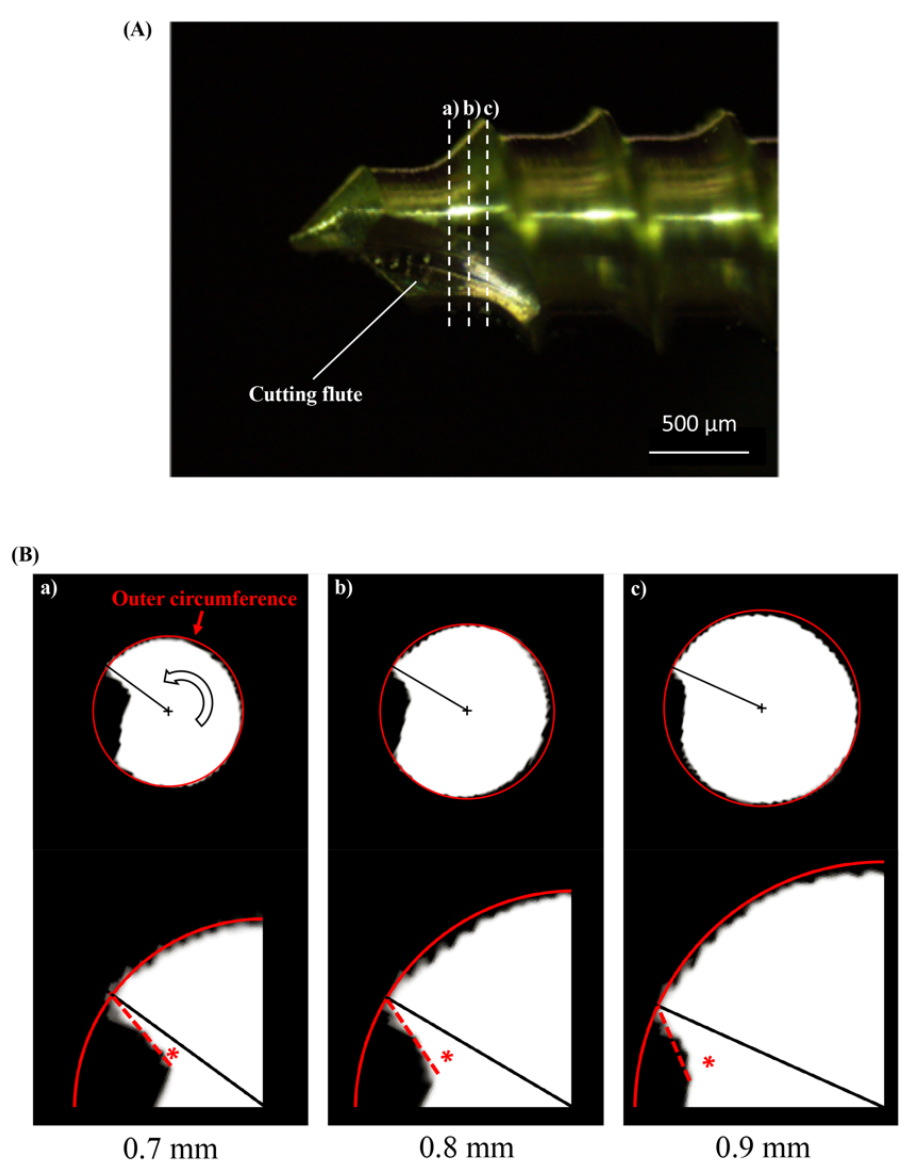
Figure A1. To investigate the effect of the cutting flute, the scoop angle of the cutting edge was examined for 0.7–0.9 mm diameter using miniscrew cross-sectional images from micro-computed tomography (micro-CT; InspeXio SMX-100CT; Shimadzu, Kyoto, Japan) scans with a tube voltage of 75 kV, tube current of 55 µ A, and voxel size of 7 µ m. The cutting flute along the screw head; ( A ) a light microscopic image (Bar = 500 µ m) and ( B ) cross-sectional micro-CT images at ( a ) 0.7, ( b ) 0.8, and ( c ) 0.9 mm. The upper panel in each set shows the whole cross-sectional image. The Red circle indicates the outer circumference of the screw, and the black cross indicates its center. The open arrow indicates the direction of rotation when the screw is inserted. Each apex of the cutting edge and the center is connected by a black line. The lower panel in each set shows its magnified view around the cutting edge. The asterisk indicates the scoop angle of the cutting